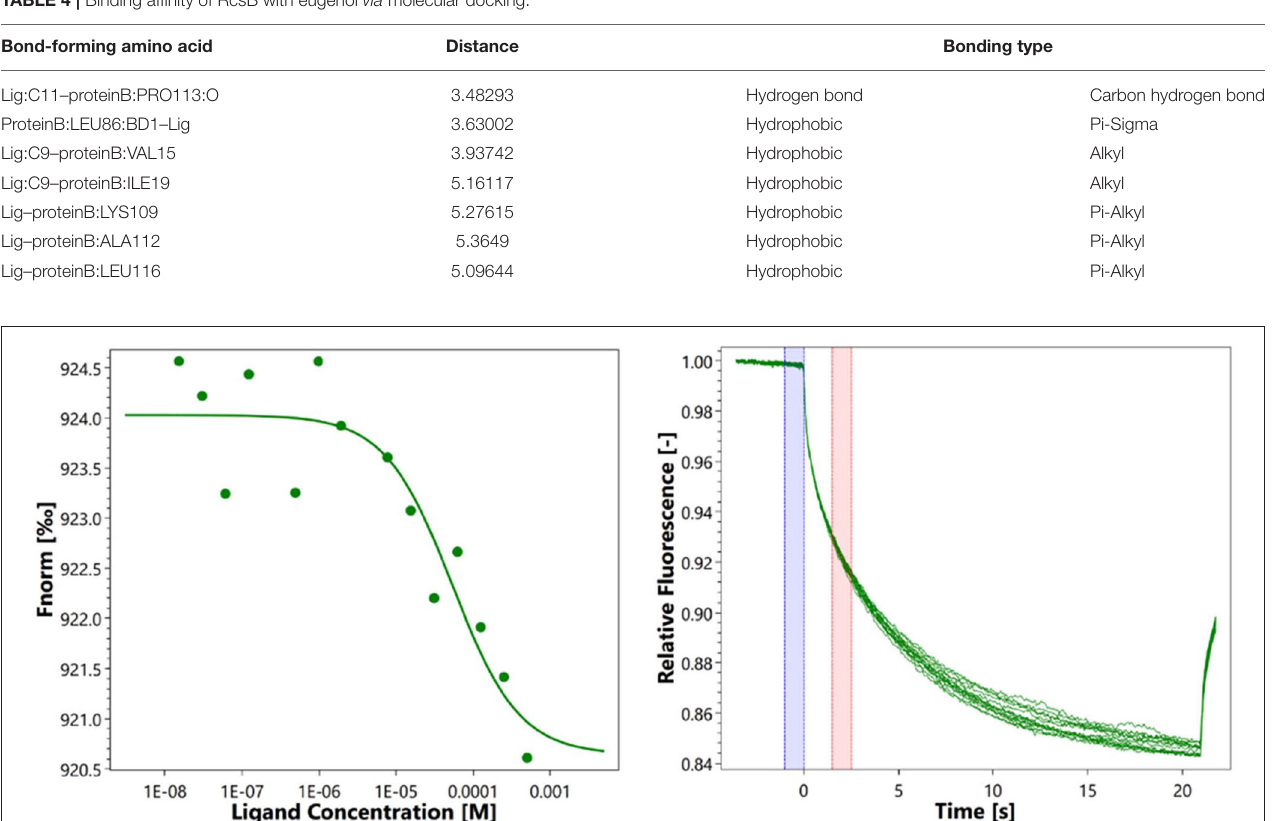
TABLE 4 | Binding affinity of RcsB with eugenol via molecular docking.